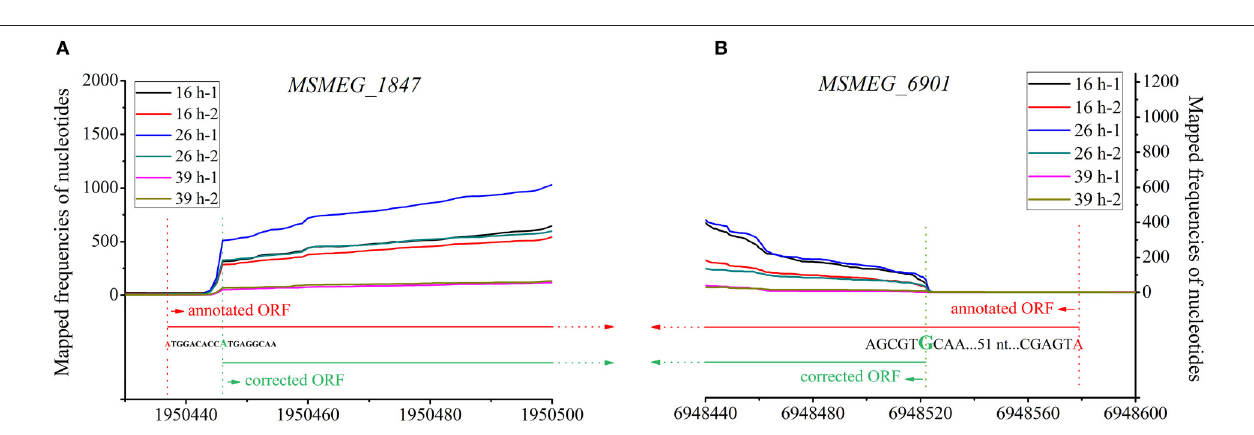
FIGURE 7 | N-terminal amino acids identification of MSMEG_4921 and MSMEG_6422. (A) and (B) respectively represent the transcriptional maps of MSMEG_4921 and MSMEG_6422 , while (C) and (D) respectively show the N-terminal five amino acids of MSMEG_4921 and MSMEG_6422 proteins. Both amino acid sequences are identical to the annotation files. Noteworthy, the N-terminal translation initiator Met was removed by methionine amino peptidase (MetAP), which is often crucial for the function and stability of proteins.